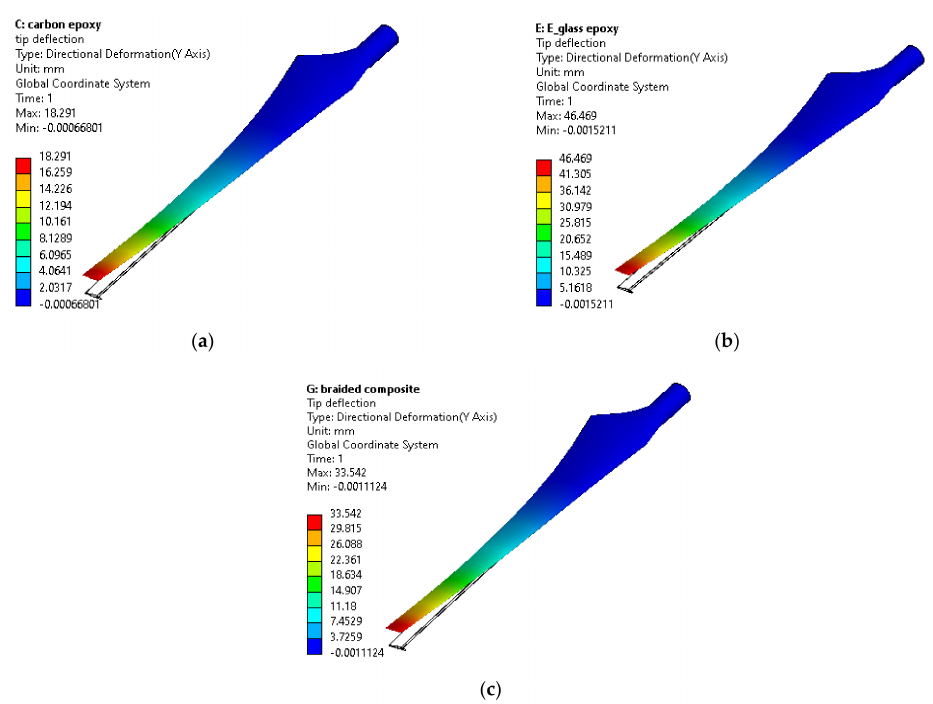
Figure 11. Tip deflections of ( a ) carbon/epoxy, ( b ) E-glass/epoxy, and ( c ) Braided composite.